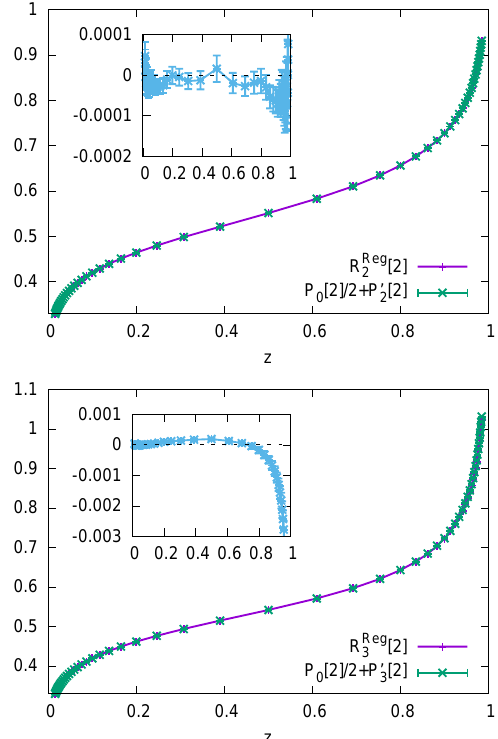
[ 2 ] + P ′ [ 2 ] and P 0 2 2